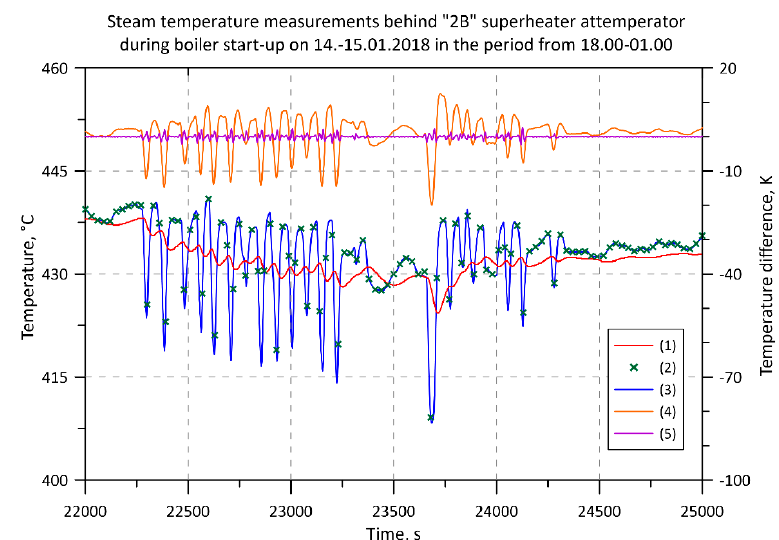
Figure 11. Comparison of superheated steam temperature downstream of the second superheater attemperator measured on side “B” in the K8 boiler: (4)—the difference between temperature measured by conventional (1) and new design ( T 1 ) (2) thermometers, (5)—the difference between temperature T 1 measured by new design thermometer (2) and T f determined using the inverse method (3).